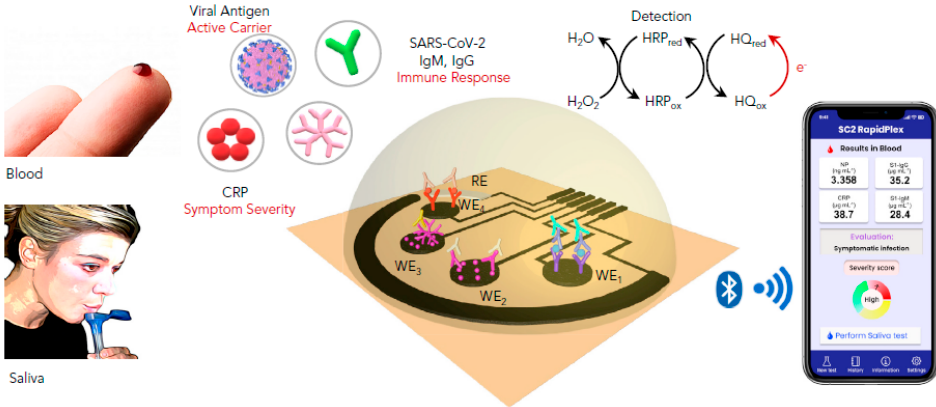
Figure 1. Schematic representation of the graphene-based electrochemical telemedicine platform for multiplexed detection of CRP, (SARS-CoV2) antigens, IgG (Immunoglobulin G) and IgM (Immunoglobulin M). This RapidPlex is composed of four graphene working electrodes (WEs); Ag/AgCl reference electrode (RE), and a graphene counter electrode (CE). All of them patterned on a polyimide (PI) substrate via CO2 laser engraving, and a fast, high-throughput. Data can be wirelessly transmitted to a mobile user interface.Reprinted with permission from [20].